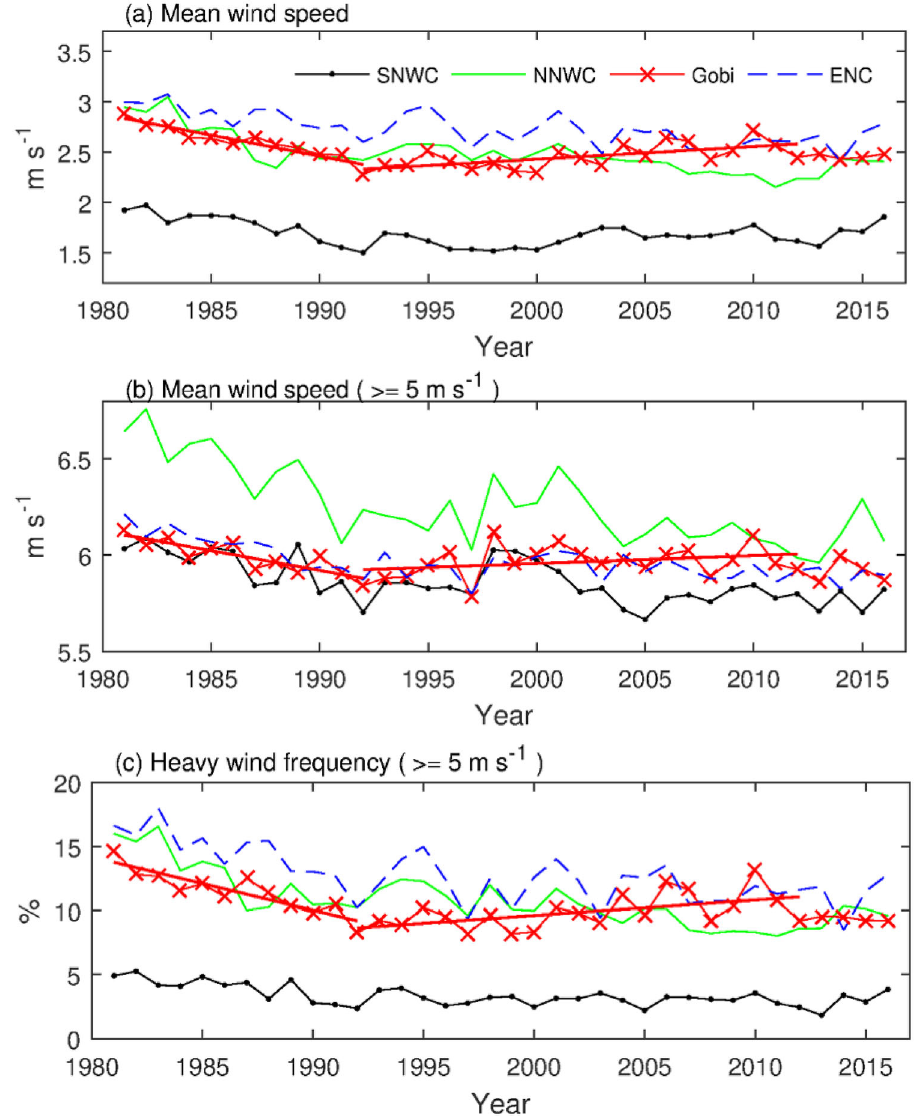
Fig. 3 Time series of mean wind speed ( a ), mean wind speed of heavy wind ( b ), and heavy wind frequency ( c ) during spring in the southern Northwest China (SNWC), northern Northwest China (NNWC), Gobi Desert, and eastern northern China (ENC) from 1981 to 2016. The straight line depicts the linear trend in mean wind speed ( a ), mean wind speed of heavy wind ( b ), and heavy wind frequency ( c ) in the Gobi